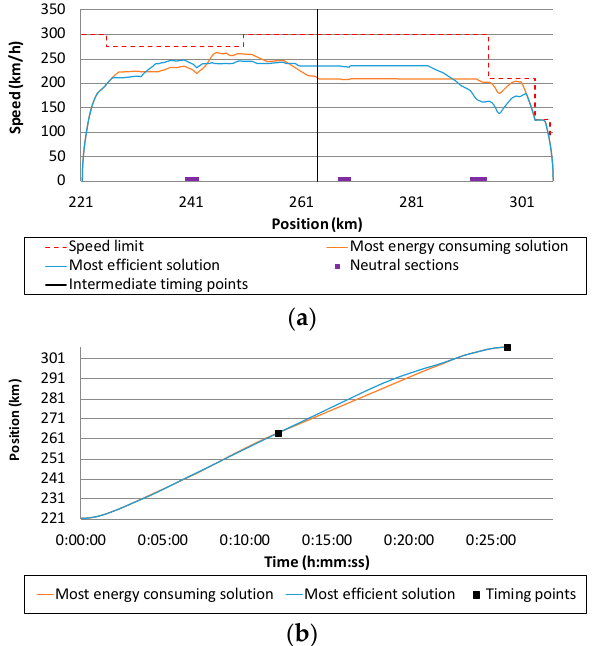
Figure 8. Speed profile ( a ) and position evolution with time ( b ) of the most efficient and most energy consuming solutions found by the algorithm for the case of one intermediate timing point.